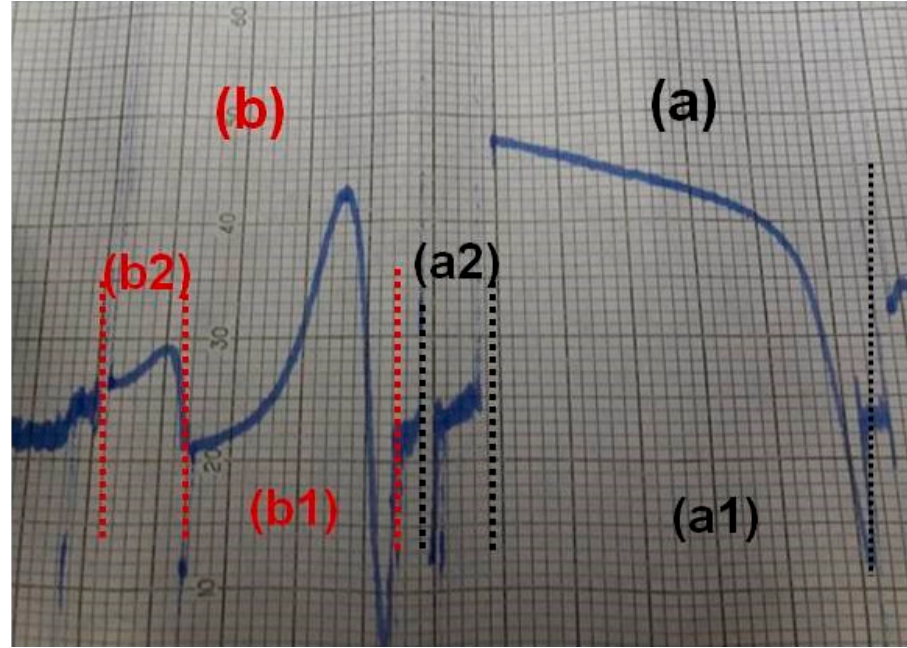
Figure 5. Representative cross-desensitization tests against PAF-induced platelet aggregation. ( a ) Platelets were activated ( a1 ) by a concentration of 2b of its EC 50 value, which is much higher (at least one to two orders of magnitude) than its IC 50 value. After the complete disaggregation of the initial 2b -induced platelet activation, platelets were stimulated ( α 2 ) by the addition of a PAF standard that can induce the same height aggregation curve. It is observed that platelets were not reactivated by the second stimulation. ( b ) Platelets were initially activated ( b1 ) by an addition of a PAF standard in platelets that induced a similar platelet aggregatory effect (similar height of aggregation curve) with that observed in ( a1 ) test by complex 2b . These platelets were not reactivated ( b2 ) at the same level after a second stimulation (immediately after complete disaggregation of the initial PAF-induced platelet activation), but instead they were only activated by approximately one fifth (approximately 80% less activation) in comparison to the activation of platelets observed in ( a1 ) test that was induced by the addition of the same concentration (EC 50 value) of 2b . The results of these tests further indicate that the Sn(II) coordination complex 2b has the ability to also act as an agonist of the PAF/PAF-receptor pathway, in higher EC 50 concentrations than its IC 50 value, and thus, it has the potential to substantially reduce the activation–aggregation of platelets induced by PAF. (PAF: platelet activating factor; EC 50 value: concentration effective in producing 50% of the maximum response; IC 50 value: inhibitory concentration that reduces the activity/binding of an inducer to its receptor and thus the associated pathway of platelet aggregation).